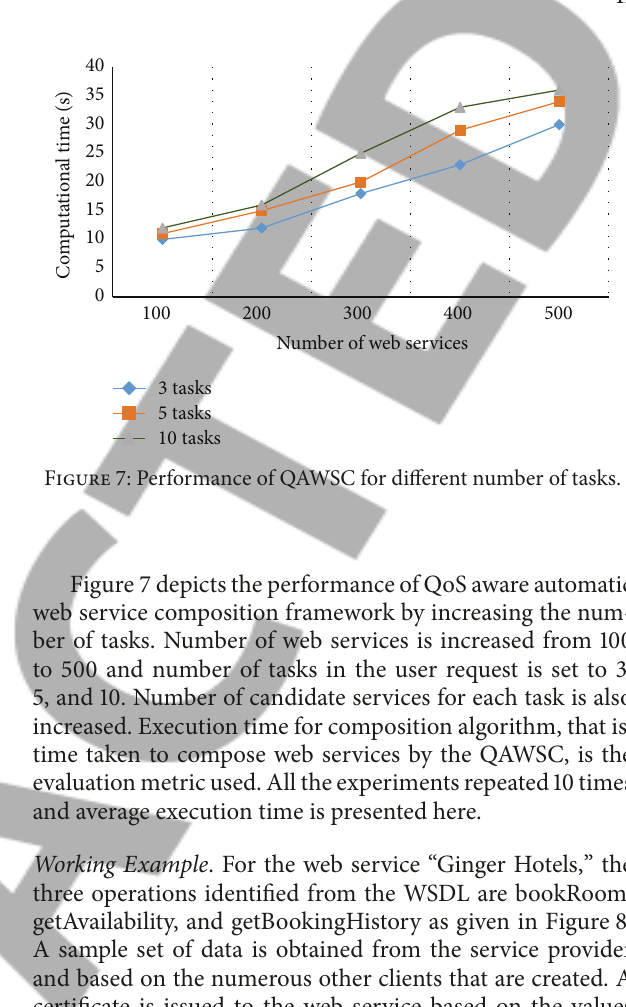
Figure 6: Performance of QAWSC.